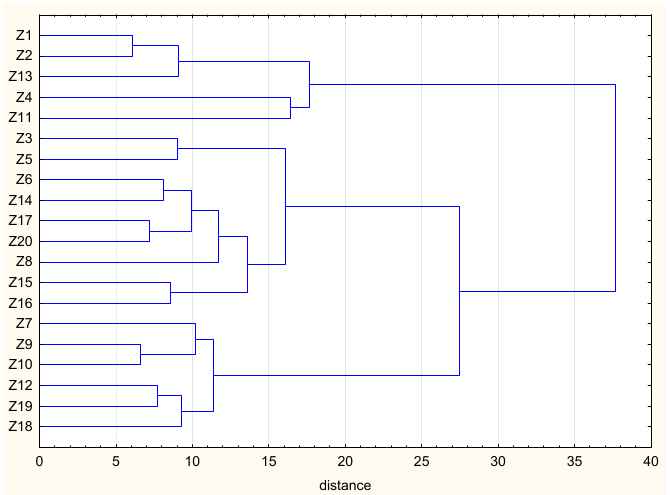
Figure 2. Cluster analysis for quality assurance variables of health worker protection measures.